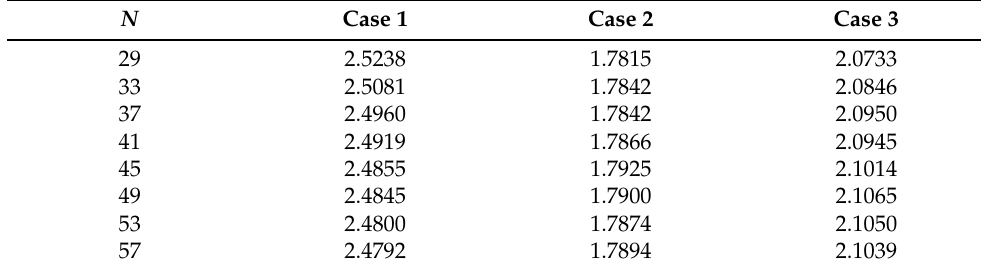
Table 4. Grid independence analysis with Ra = 10 5 , Ha = 10, kr = 1, A = 0.05, n = 3, γ = 0 ◦ .